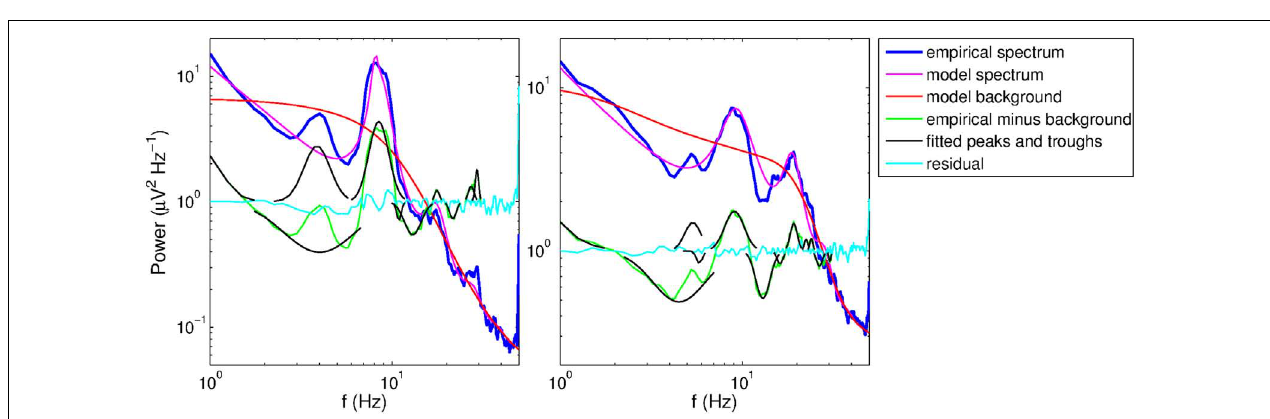
FIGURE 6 | Example spectra from two subjects with overlapping theta peak and trough. The residuals and fitted peaks and troughs (in log power) are exponentiated for visual clarity on the logarithmic